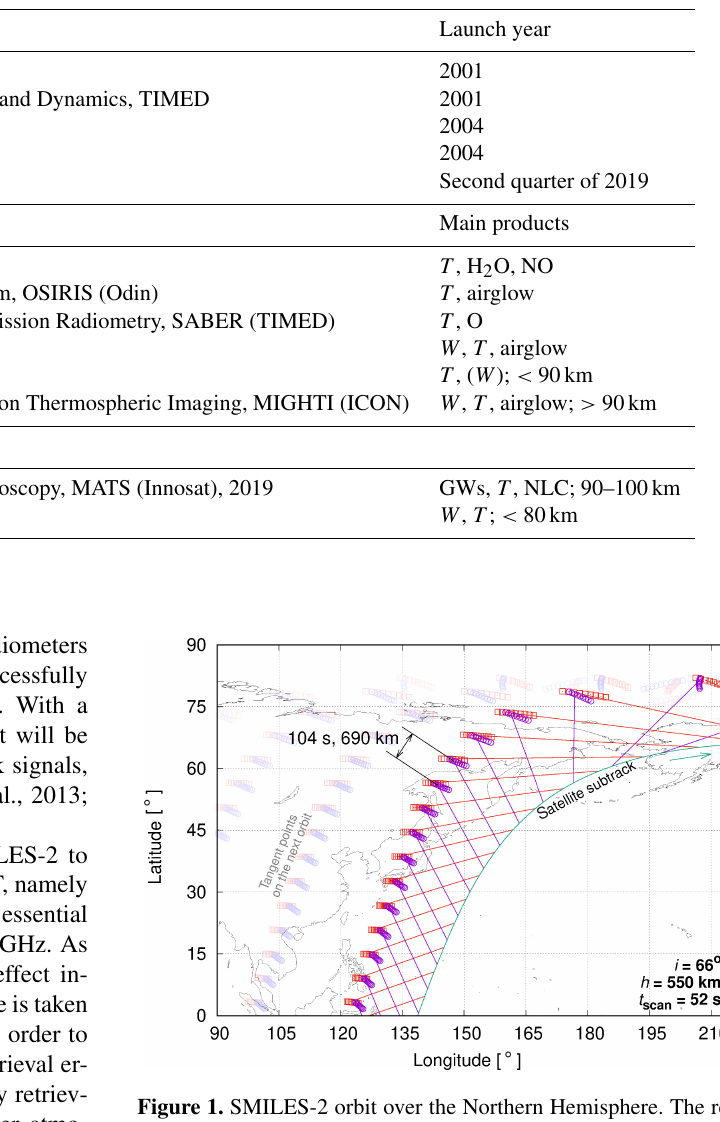
Figure 1. SMILES-2 orbit over the Northern Hemisphere. The red and purple lines show the forward and aftward lines of sight (LOSs). The circles show the tangent-point footprints (Ochiai et al.,